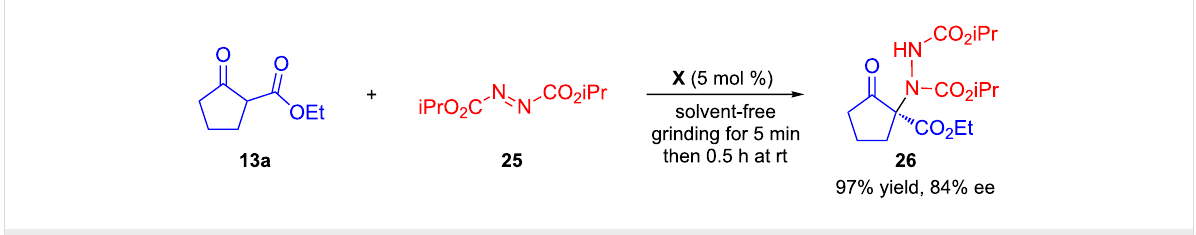
Scheme 12: Enantioselective amination of β -ketoester by using pestle and mortar.